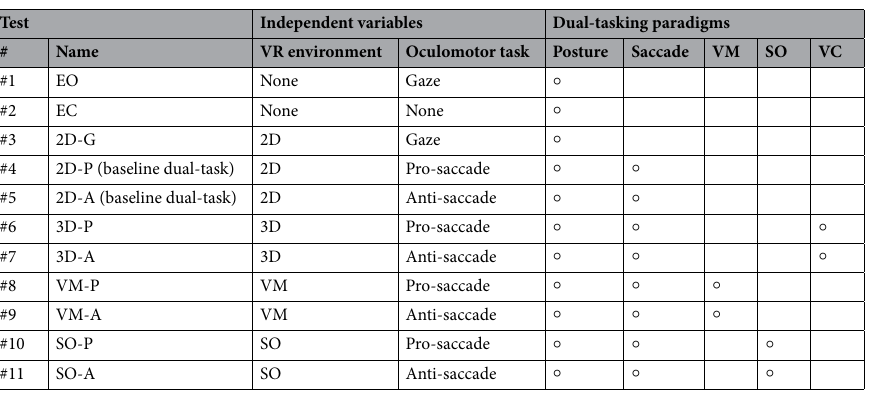
Table 2. Experimental conditions for concurrent comprehensive assessment of postural sway and saccadic eye movements with VR ( EO eyes-open, EC eyes-closed, VM visuospatial memory, SO spatial orientation, VC visual